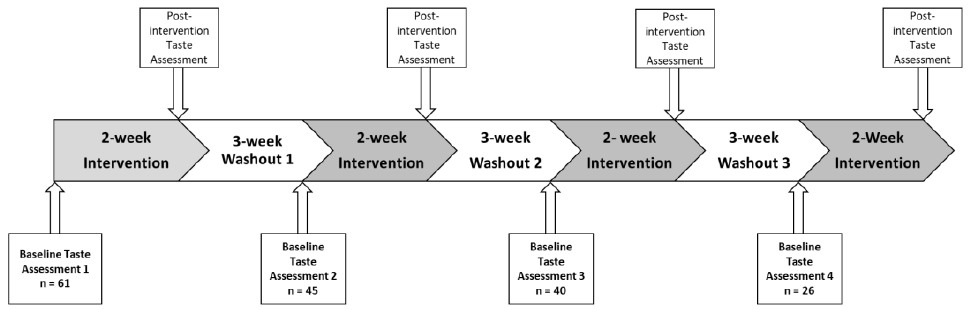
Figure 1. Outline of the larger intervention study; this study explored the baseline taste assessments prior to each intervention arm, and the total number of participants that completed each baseline taste assessment is outlined. All taste outcome measures were assessed at each repeat baseline taste assessment, including the discrimination status assessment, detection threshold, recognition threshold, and suprathreshold for salt, monosodium glutamate (MSG), monopotassium glutamate (MPG), and sucrose.